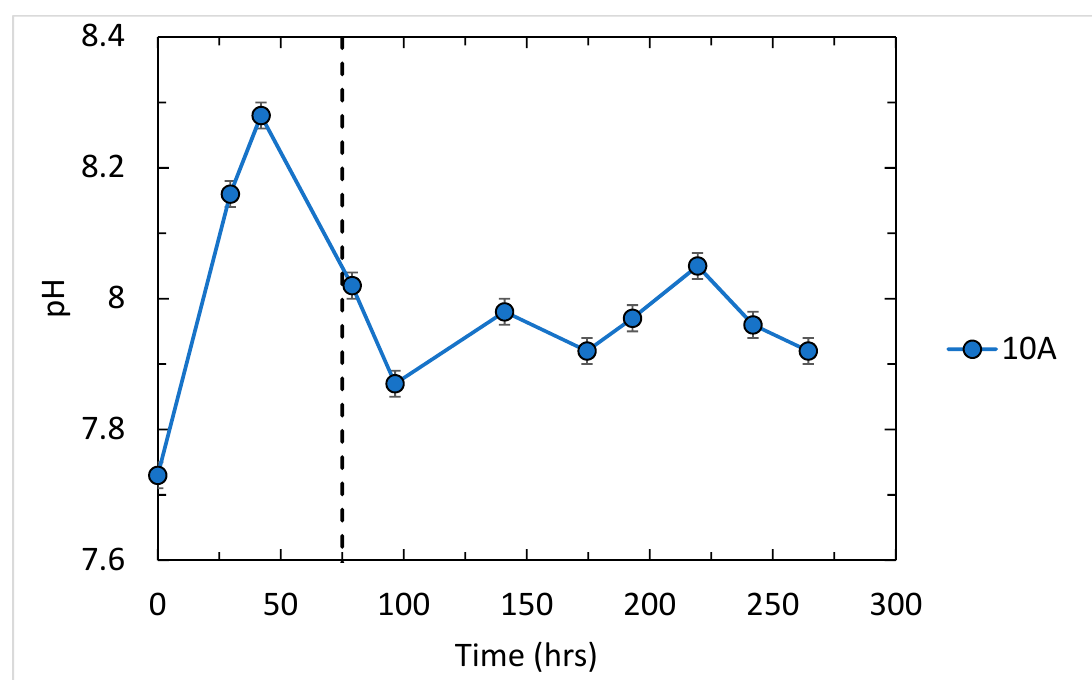
Figure 3. Graphical representation of pH plotted against time for experiment 10A. The analytical uncertainty was ± 0.02. The vertical dashed line indicates the observed onset of crystallization at approximately 75 h.